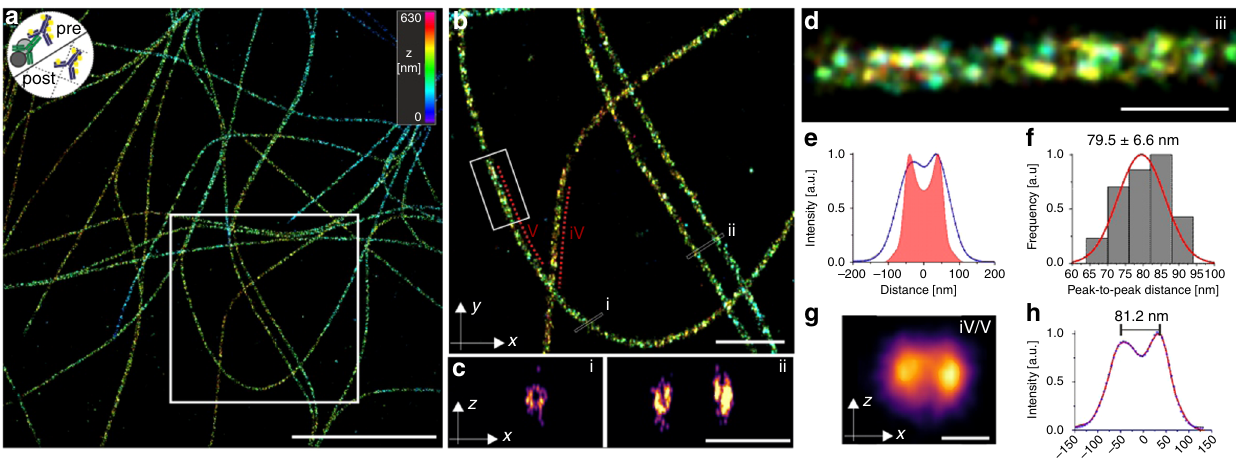
Fig. 3 3D post-labeling Ex- d STORM. SMLM image of re-embedded and post-expansion labeled microtubules. a 3D d STORM image of re-embedded Cos-7 cells expanded according to the Protein-Retention protocol (proExM) 4 pre-labeled with anti α - and β -tubulin antibodies and additionally post-labeled with anti α -tubulin. The secondary antibodies were labeled with Alexa Fluor 532 (proExM Al532). The small logo in the upper left corner symbolizes the labeling method, e.g. pre- and post-immunolabeling with Al532 secondary antibodies. b Magni fi ed view of highlighted region in ( a ). c xz -side view cross-sections (white lines) (i) and (ii) shown in ( b ) revealing the hollow structure of microtubules. d Magni fi ed view of highlighted region (white box) in ( b ). Since post- labeling dominates the signal, the method is termed proExM Al532 (post-labeled). e Averaged cross-sectional pro fi le (blue) of 11 analyzed microtubule segments along a total of 28.2 µ m fi lament (2.1 – 5.5 µ m segments) of one expanded sample. The simulated cross-sectional pro fi le for 3.2x proExM expanded pre- and post-labeled microtubule assuming a pre- to post-labeling ratio of 0.1 is shown in red. f Histogram of peak-to-peak distances with normalized normal curve (red) of fi tted pro fi les analyzed in ( e ) with an average distance of 79.5 ± 6.6 nm (mean ± sd) analyzed along n = 11 microtubule segments in 2 cells from 1 expanded sample. g Image projection of the xz -axes averaged along two microtubule fi laments (iv) and (v) shown in ( b ) (red dotted lines) using the “ z projection analysis ” of the software “ Line Pro fi ler ” . h Cross-sectional pro fi le (blue dots) of the xz -projection shown in ( g ). Using a bi-Gaussian fi t (red) the peak-to-peak distance is determined to 81.2 nm. Scale bars, 10 µ m ( a ), 5 µ m ( b ), 1 µ m ( c ), 500 nm ( d ), 100 nm ( g